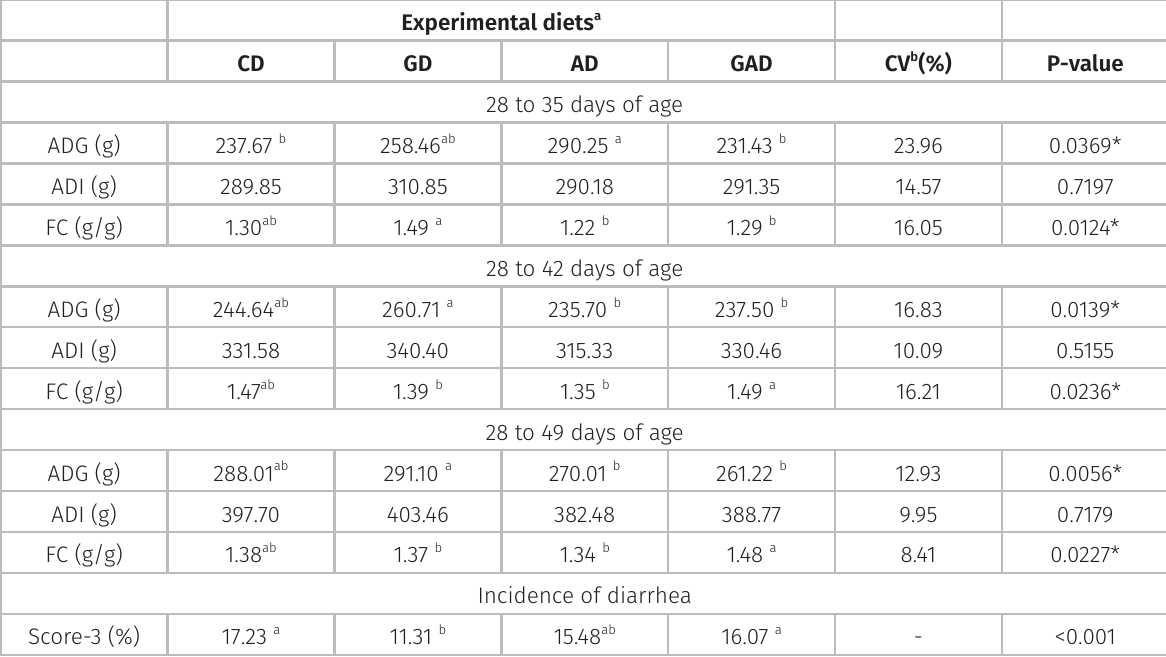
Table IV. Effects of the addition of L-glutamine + glutamic acid or L-arginine to the diet of newly weaned piglets